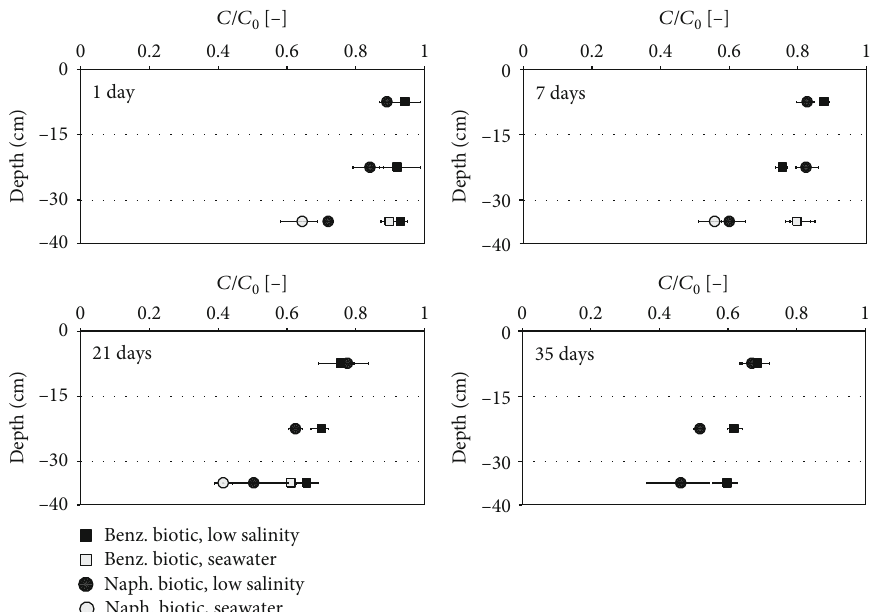
Figure 4: Summary of normalized aqueous concentration losses of benzene (Benz.) and naphthalene (Naph.) due to simultaneous sorption and biodegradation in biotic microcosms as a function of depth and salinity. The horizontal gray lines represent the limits between the soils A1, A2 and A3 from the